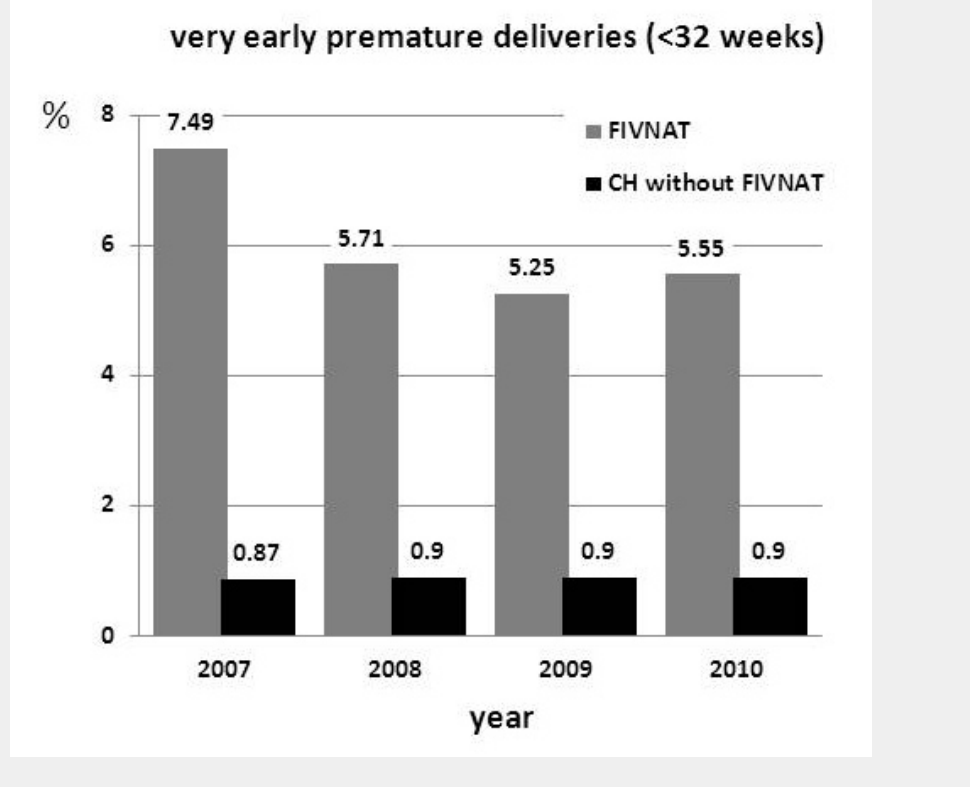
Figure 5 The incidence of very early premature delivery (before week 32 of gestation) is much higher in assisted reproduction than in natural conception (Source: BfS and FIVNAT ■■■). Although many cases of very early prematurity are caused by multiple delivery including twins, the risk is also higher in singleton pregnancies among previously infertile